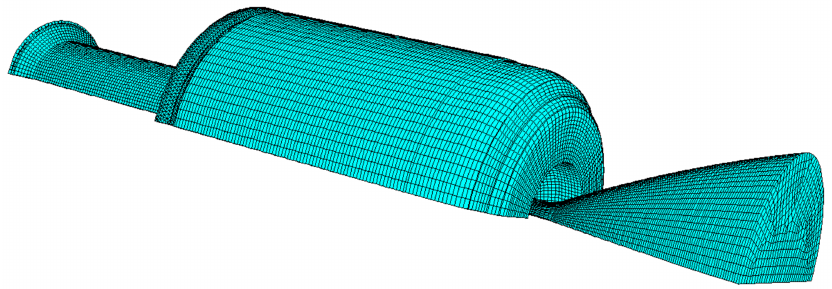
Figure 3. The mesh diagram of the calculation model (t = 2